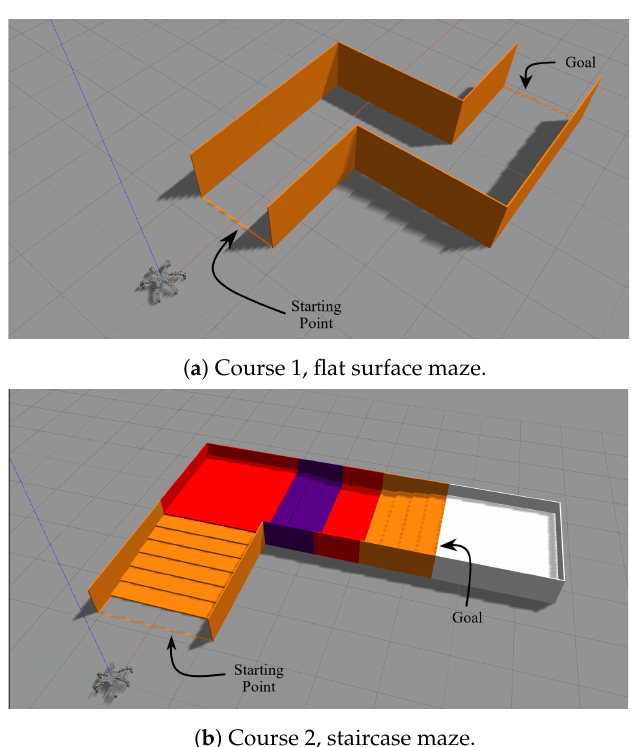
Figure 8. Teleoperated locomotion tasks. ( a ) demonstrates a baseline case for which all useful interfaces should perform similarly, while ( b ) introduces challenging and non-ideal terrain. In ( b ), orange indicates ascending, purple indicates descending, red indicates flat, and white indicates